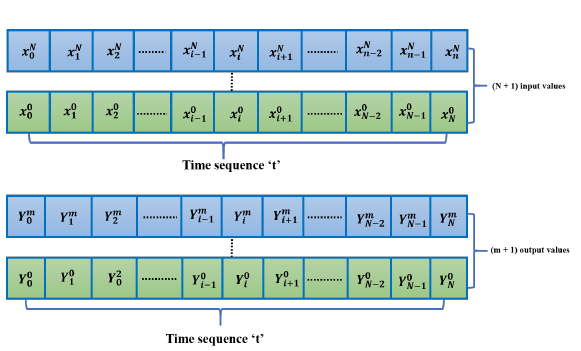
Figure 3. Overview of the input data x t over a time sequence t with n + 1 values and output data Y t over a time sequence t with m + 1 values.